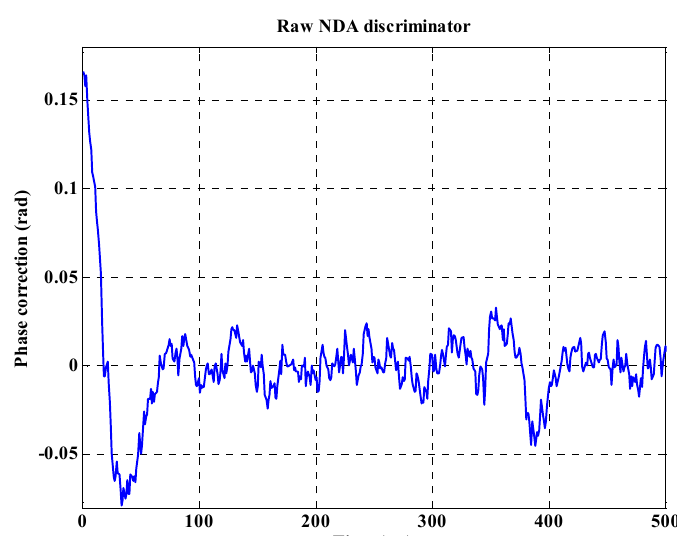
Figure 6 – Signal at the output of the phase discriminator for the NDA algorithm Рис .6 – Сигнал на выходе фазового дискриминатора для алгоритма